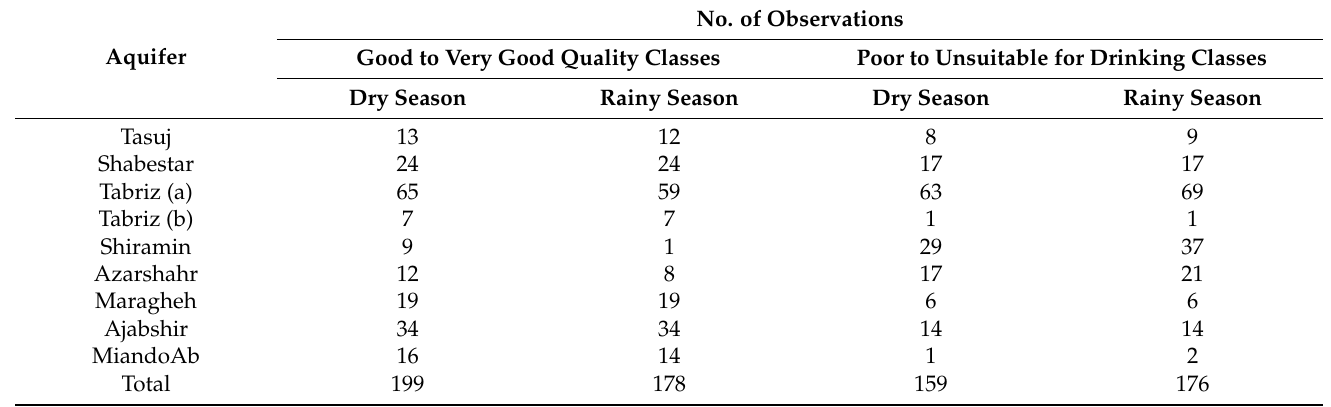
Table 2. Assessment of the quality of groundwater for drinking purposes based on the WQI. Number of observations: 358 observations in the dry season and 354 observations in the wet season.